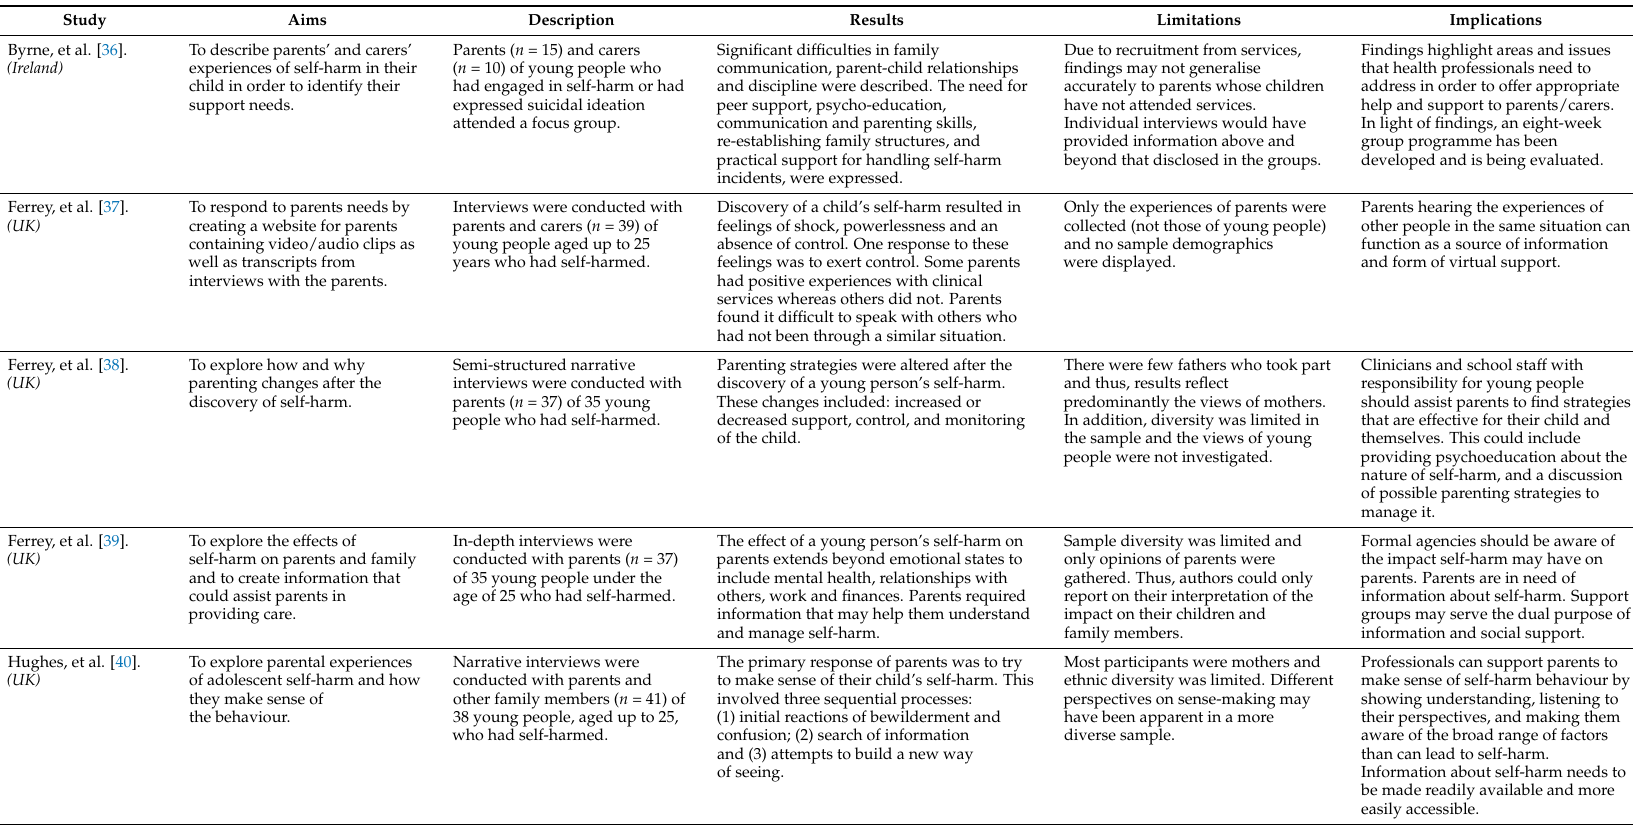
Table 2. Articles that examined the perspectives of parents and carers ( n =